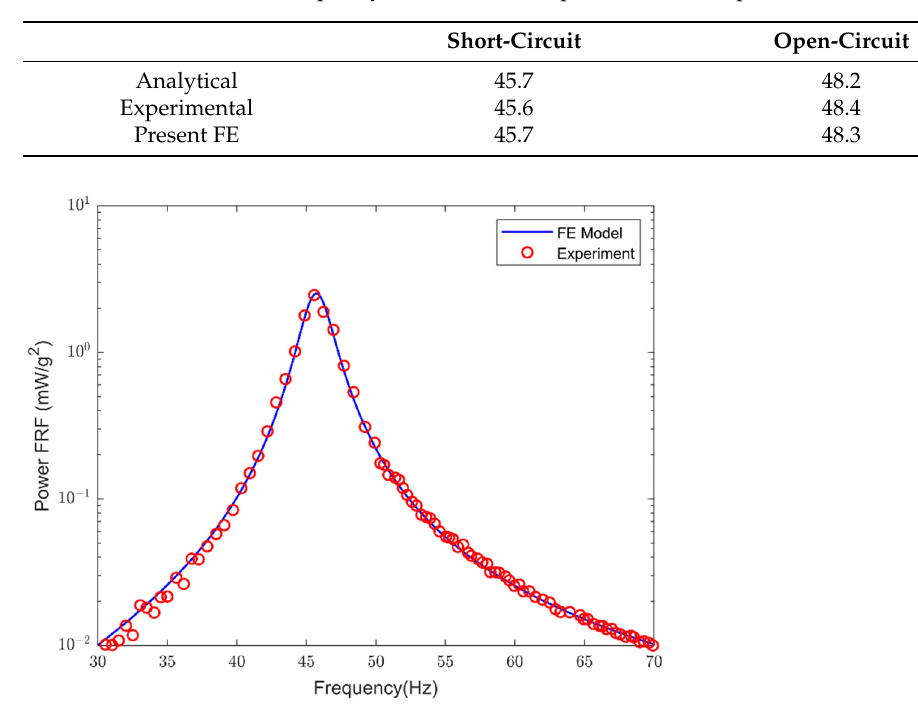
Table 2. The fundamental frequency (Hz) of the bimorph harvest with tip mass [7].